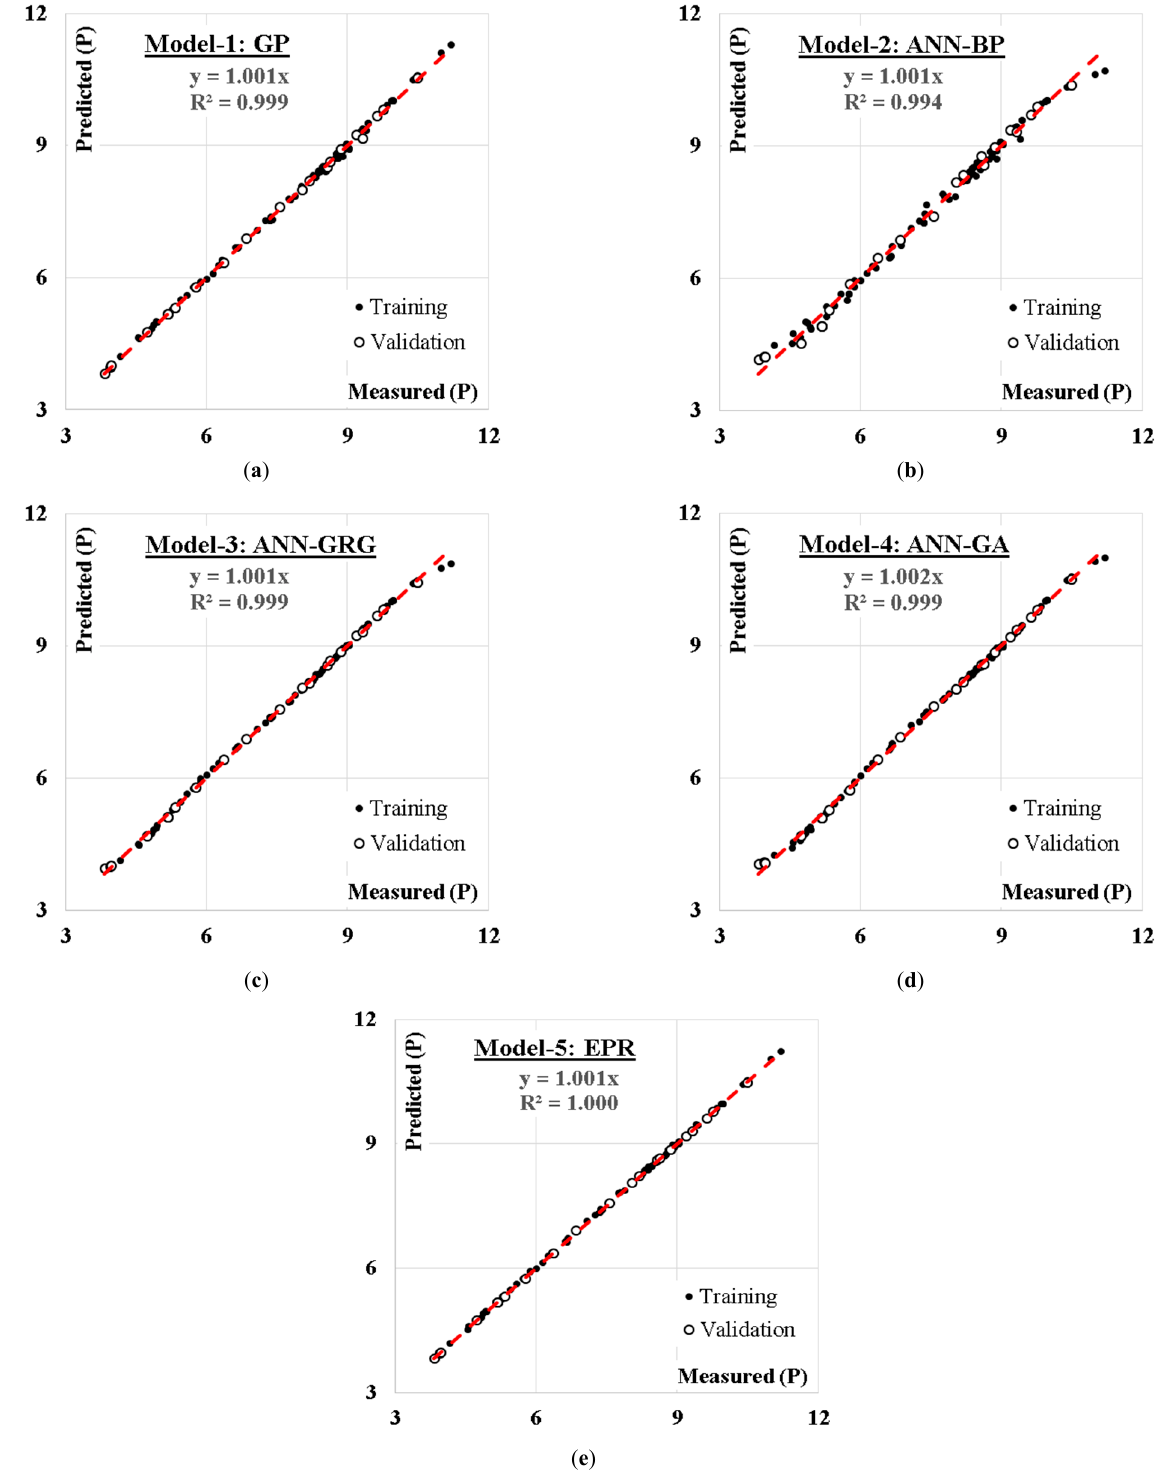
Figure 9. Relation between predicted and calculated P values using the developed models. ( a ) Model-1: GP; ( b ) Model-2: ANN-BP; ( c ) Model-3: ANN-GRG; ( d ) Model-4: ANN-GA; ( e ) Model-5: EPR. Khursheed et al. [73] investigated predictions for the compressive strength of fly ash concrete by adopting minimax probability machine regression (MPMR), a relevance vector machine (RVM), genetic programming (GP), an emotional neural network (ENN) and an extreme learning machine (ELM). In this research into the 28-day-cured compressive